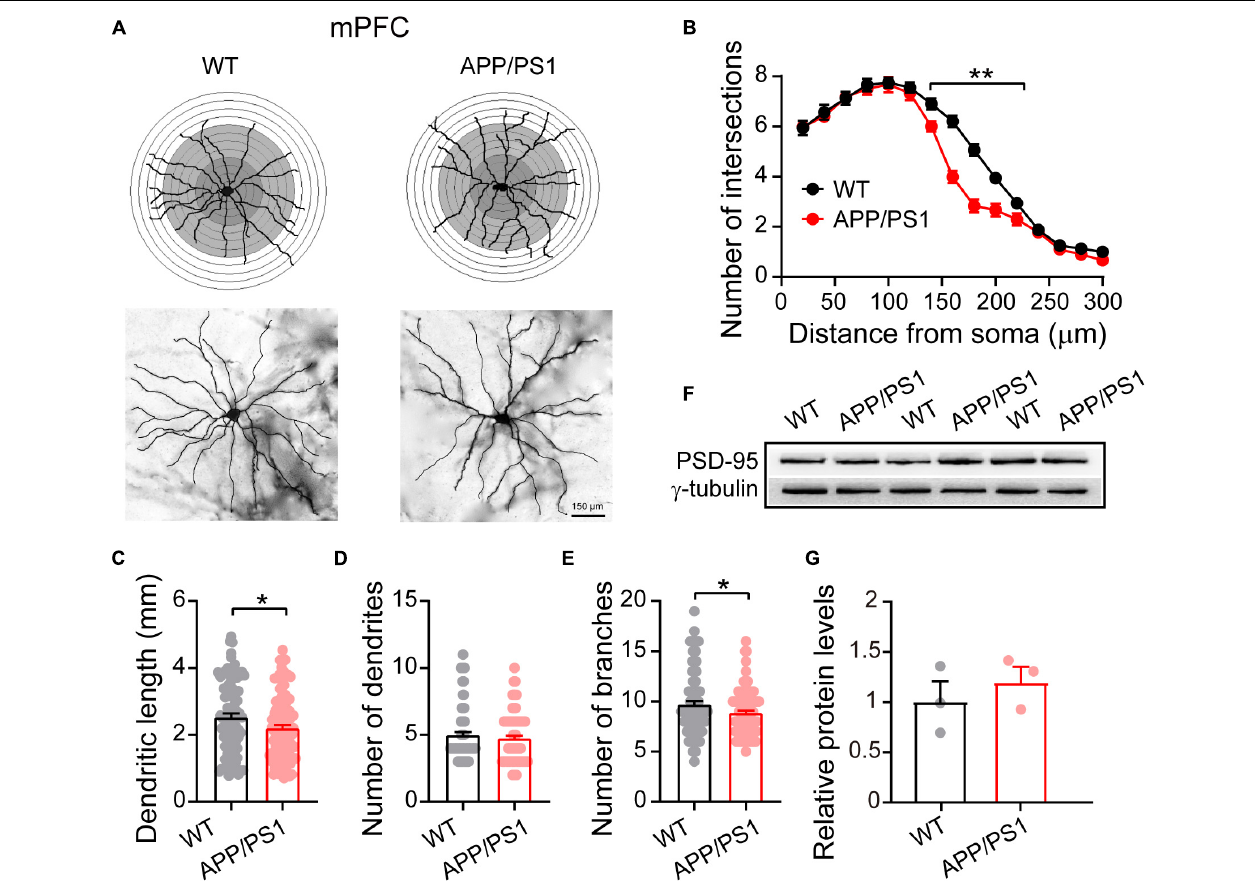
FIGURE 2 | Altered dendritic morphology in the mPFC of 4 ∼ 5-month-old APP/PS1 mice. (A) Schematic photomicrographs of neurons with the allocation of dendrites between repeated 20 µ m-spaced concentric rings. (B) APP/PS1 mice have fewer intersection points than age-matched WT mice (at a distance of 140–220 µ m from the soma). (C–E) The dendrite length and number of branches of PFC neurons are significantly decreased in APP/PS1 mice compared with age-matched WT animals ( n = 100 neurons from 4 animals per genotype; one-way ANOVA). (F) Representative immunoblotting images of PFC extracts and (G) quantification of blots indicate identical levels of PSD-95 in APP/PS1 mice compared with age-matched controls ( n = 3 mice per genotype; two-sample t -test). Each value represents the mean ± SEM; * p < 0.05, ** p <